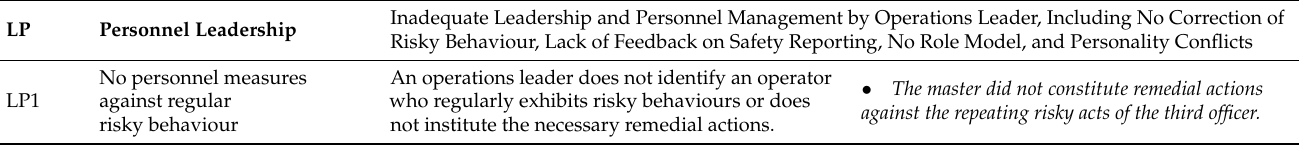
Table A3. Codes, titles, definitions, and guidance and examples of categories and factors in the Operational Leadership